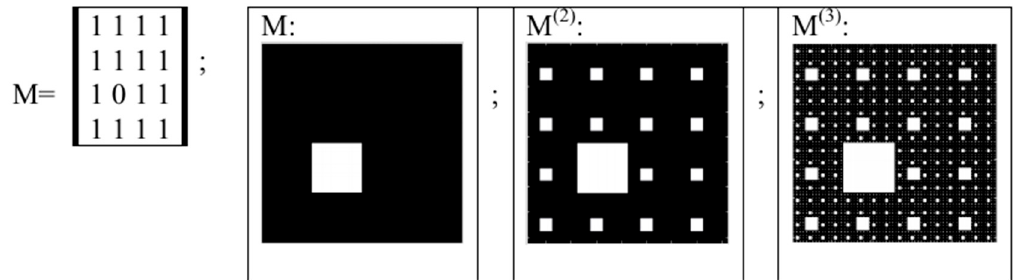
Figure 8. An example of generating fractal lattices by means of Kronecker exponentiation of matrices. Left side: the (4 × 4)-matrix M with entries 0 and 1. Right side: visual patterns of the matrix M and its Kronecker powers M (2) and M (3) , which are (16 × 16)-matrix and (64 × 64)-matrix respectively. Here, black corresponds to matrix cells with entries of 1 and white corresponds to cells with entries of 0.